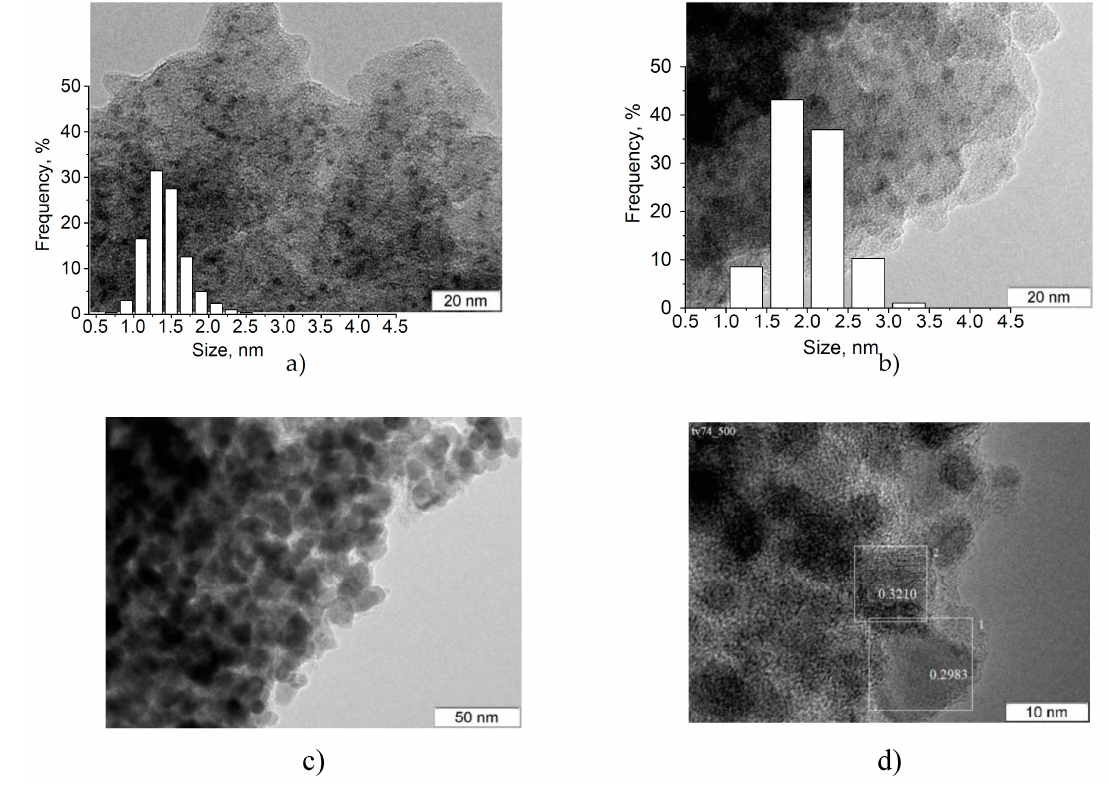
Figure 3. Images of TEM MoP_A ( a ), MoP_I ( b ), bulk MoP ( c , d ).